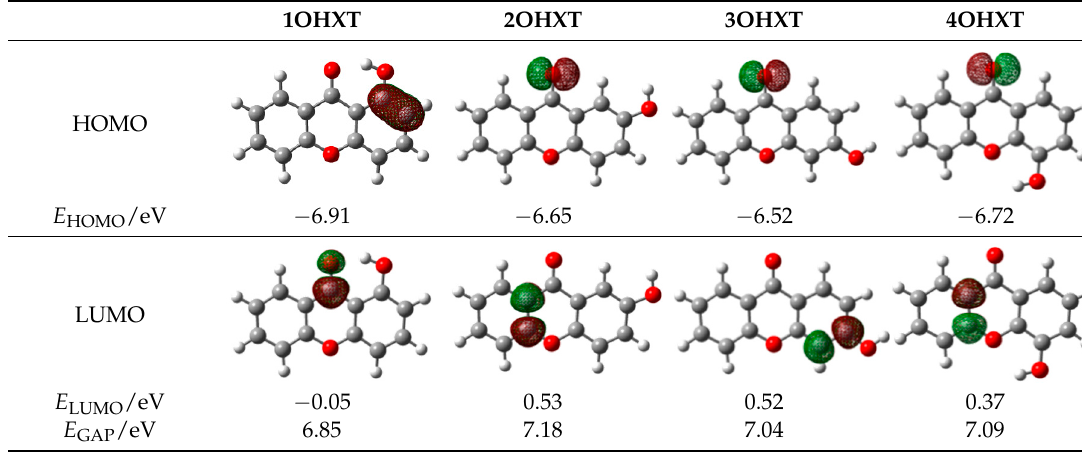
a Spheres colour code: grey, C; red, O; white, H.